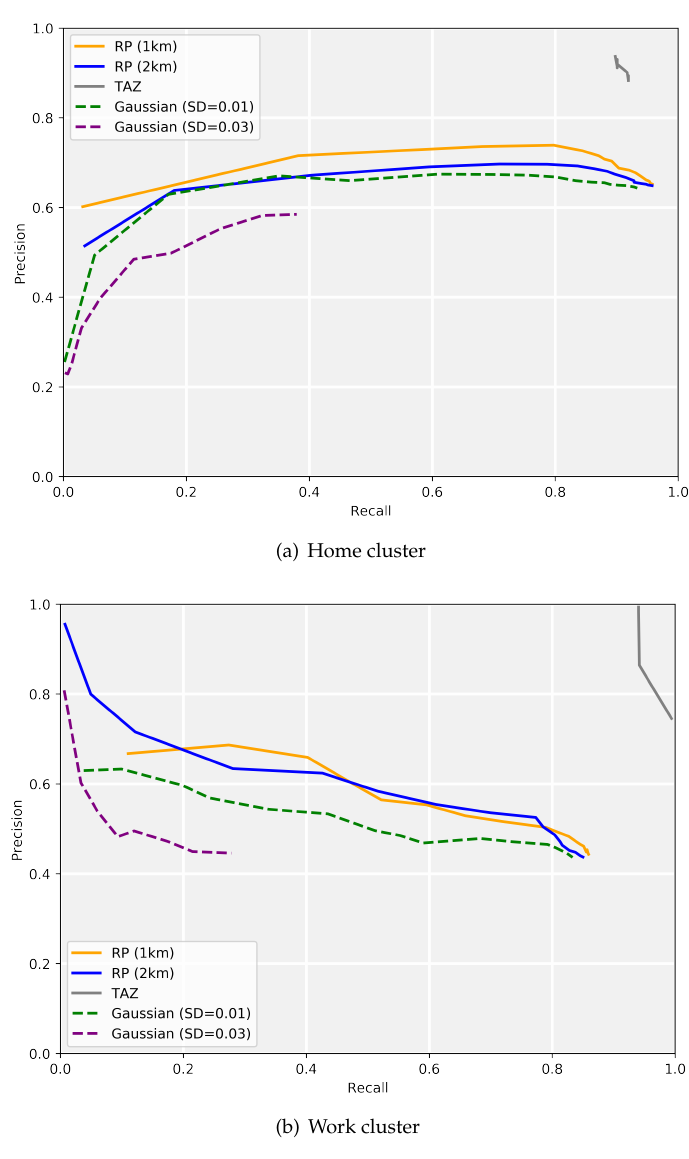
Figure 9: Precision-Recall curves of different geomasking